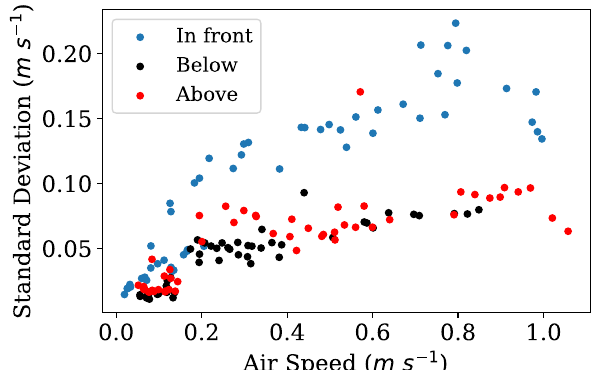
Figure 9. Distribution of error for each air speed sensor’s measurements, positioned ‘In front’ of, ‘Below’, and ‘Above’ the globe thermometers. Air speed measurements taken in front of the sensor were used for each analysis, as the mean values produced the highest fidelity results using the mixed convection model, despite the largest relative